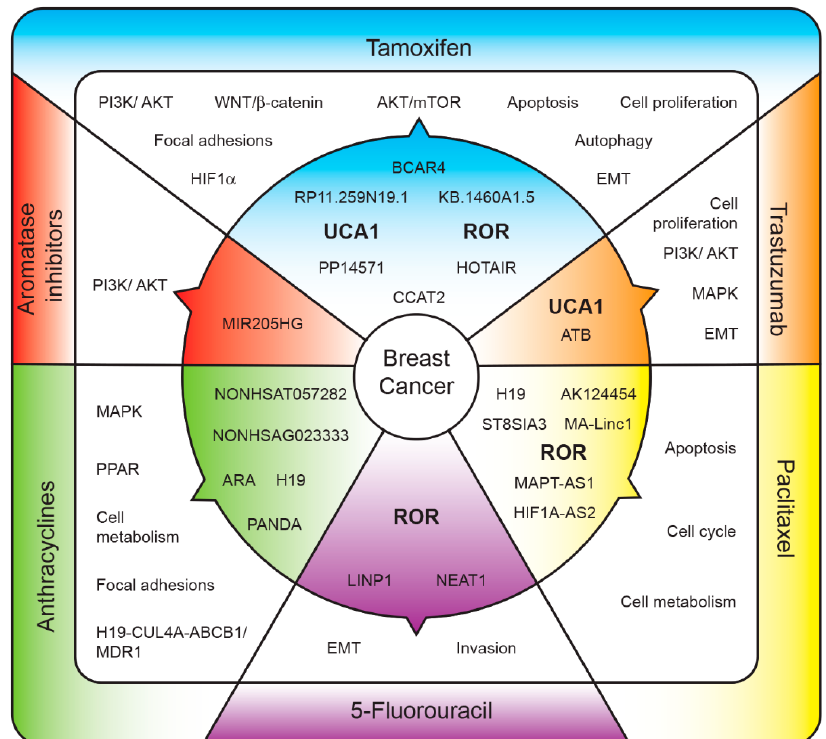
Figure 1. Long non-coding RNAs (lncRNAs) associated with treatment resistance. Upregulated lncRNAs (inner section) regulate several pathways (middle section) that ultimately lead to resistance to systemic treatments (outer section). LncRNAs: BC anti-estrogen resistance 4 (BCAR4), Urotelial carcinoma-associated 1 (UCA1), RNA regulator of reprogramming (ROR), Hox antisense intergenic RNA (HOTAIR), Colon cancer-associated transcript 2 (CCAT2), lncRNA activated by transformig growth factor-beta (ATB), Mitosis-Associated Long Intergenic Non-Coding RNA 1 (MA-Linc1), MAPT antisense RNA 1 (MAPT-AS1), HIF antisense RNA 2 (HIF1A-AS2), lncRNA in non-homologous end joining (NHEJ) pathway 1 (LINP1), ncRNA nuclear paraspeckle assembly transcript 1 (NEAT1), adriamycin resistance-related lncRNA (ARA), lncRNA P21-associated lncRNA DNA damage activated (PANDA). Pathways: Phosphatidylinositol 3-kinase/Serine/Threonine Kinase 1 (PI3K/AKT), Mitogen-activated protein kinase (MAPK), peroxisome proliferator-activated receptor (PPAR), epithelial-mesenchymal transition (EMT), Treonine Kinase1/mammalian target of rapamycin complex 1 (AKT/MTOR), Hypoxia-inducible factor 1-alpha (HIF1 α ), Cullin-4A (CUL4A), ATP Binding Cassette Subfamily B Member 1 (ABCB1), Multi-Drug Resistance Gene